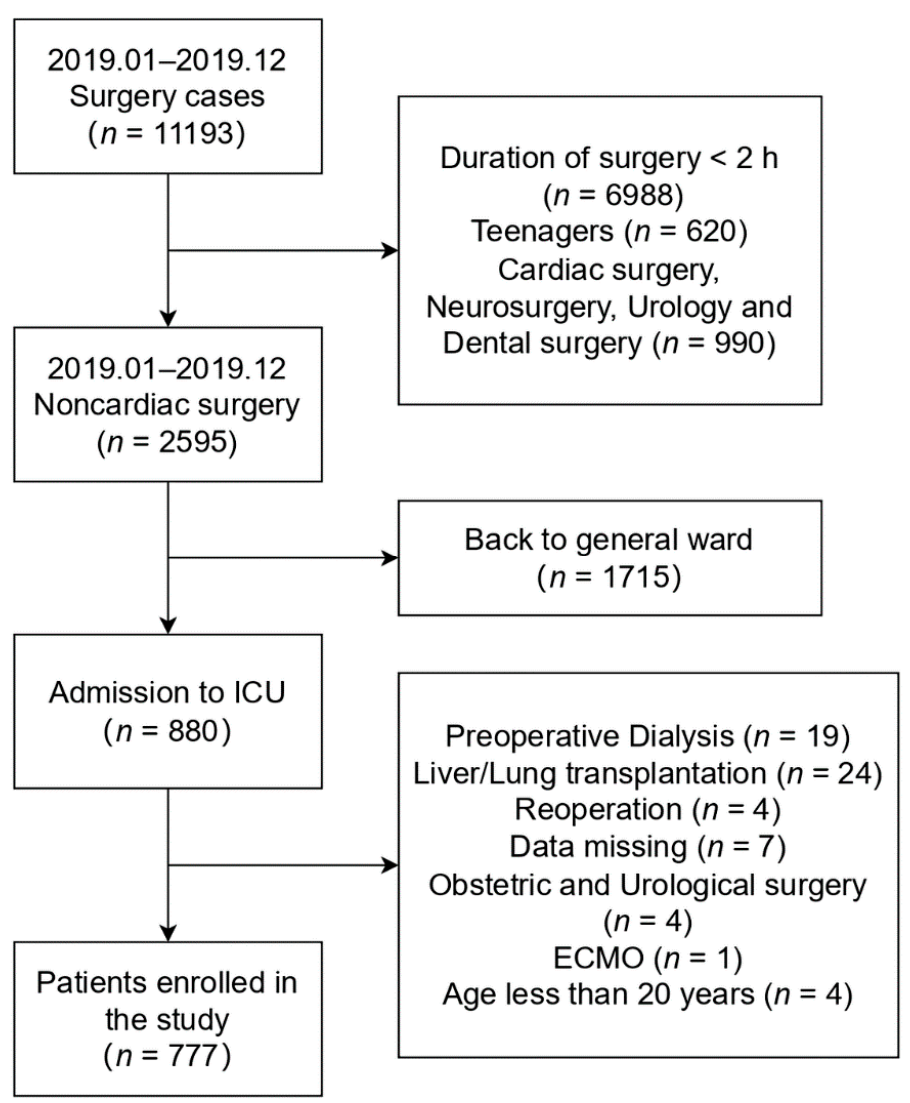
Figure 1. Flow chart. ICU = intensive care unit; ECMO = extracorporeal membrane oxygenation.